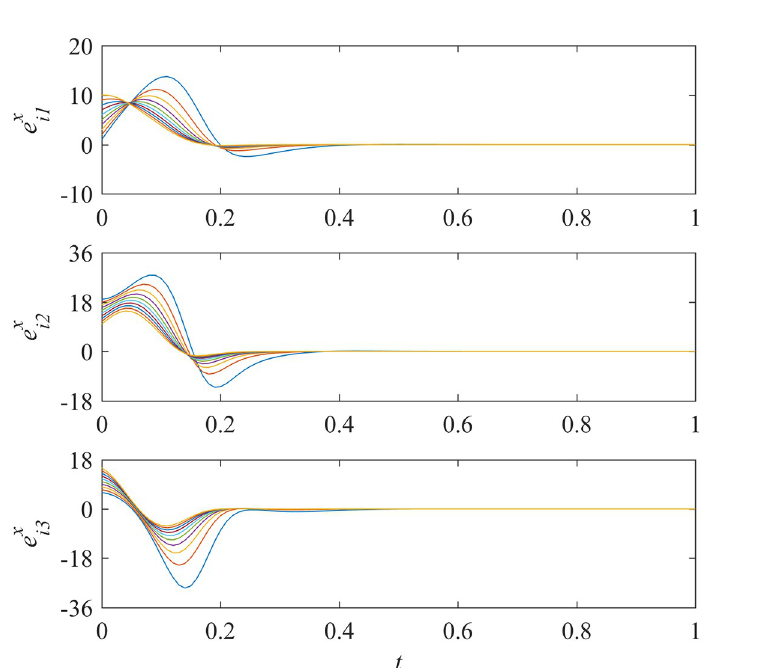
Fig 11. States of error system between the nodes and the isolate node in sub-network X which is immune to the cascading failure.